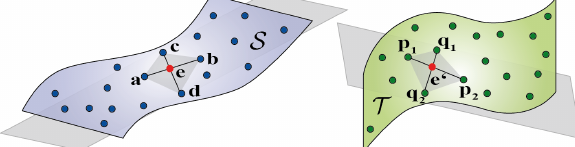
Figure 1: Principle of 4PCS with base set B ( a , b , c , d ) ∈ S and a corresponding congruent point set M ( p 1 , p 2 , q 1 , q 2 ) ∈ T making use of the diagonal intersection point e